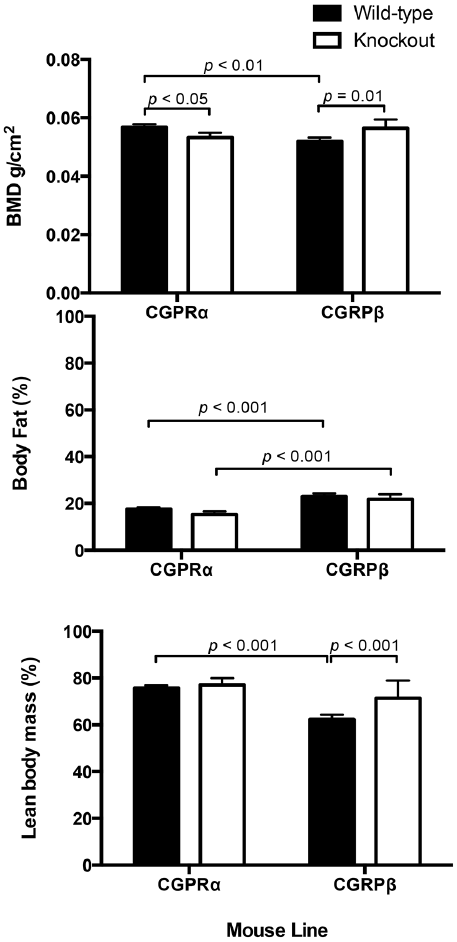
Fig. 7. Deletion of the CGRP gene had opposite effects on bone mineral density (BMD) in CGRP a and CGRP b mice. BMD was decreased in CGRP a knockout mice ( p , 0.05) and increased in CGRP b knockout mice ( p 5 0.01), relative to their respective wildtype groups. In wildtype mice, BMD was decreased in Swiss background strain for the CGRP b mice, relative to the C57BL/6 mice background strain for the CGRP a mice. C57BL/6 mice had a lower percentage body fat than Swiss mice ( p , 0001). In Swiss mice, deletion of CGRP b function was associated with increased lean body mass ( p , 0.001). BMD was determined using a PIXImus densitometer, n 5